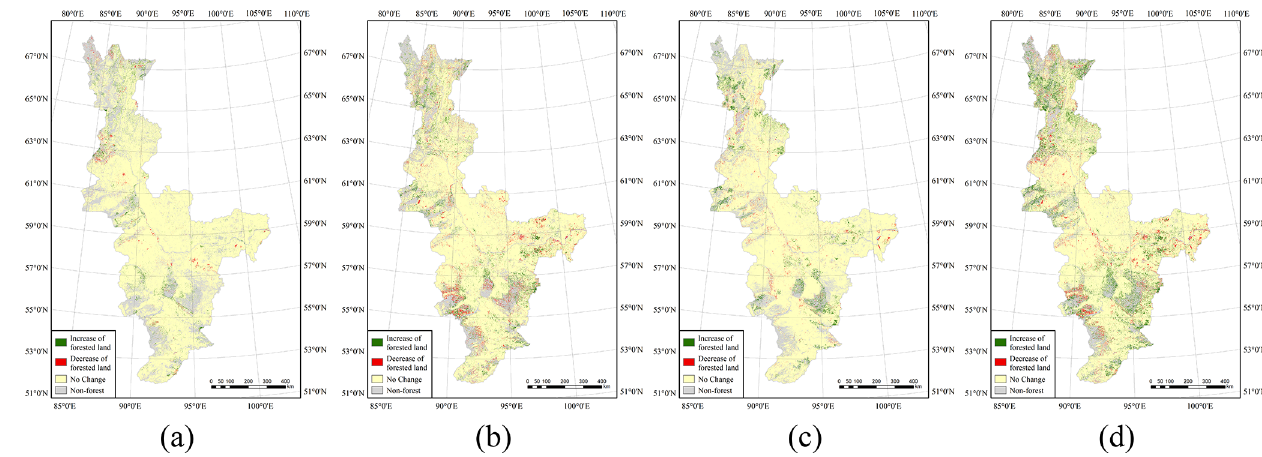
Figure 4. Changes in boreal forest coverage in the time intervals (a) 1985–1995, (b) 1995–2005, (c) 2005–2015 and (d)